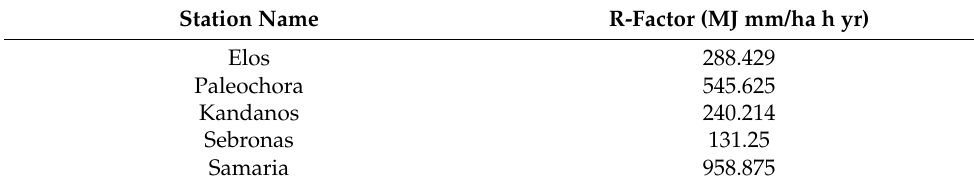
Figure 5. Shaded relief map of Chania (western part of Crete Island) showing the locations and spatial distribution of the meteorological (rain gauges) stations used in the current research. Table 8. R-factor values for the precipitation